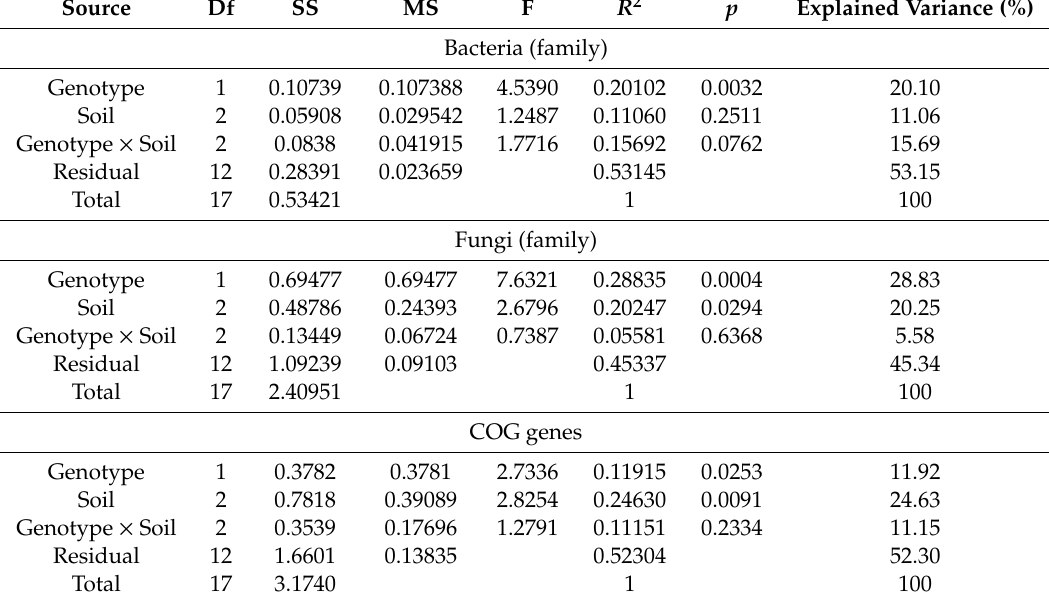
Table 2. PERMANOVA analysis of meta-transcriptome diversity and functioning in relation to host genotype, soil, and its interaction. Df = degrees of freedom; SS = sum of squares; MS = mean sum of squares; Pseudo-F = F value by permutation. Statistical significance is indicated in bold ( p < 0.05); p -values are based on 999